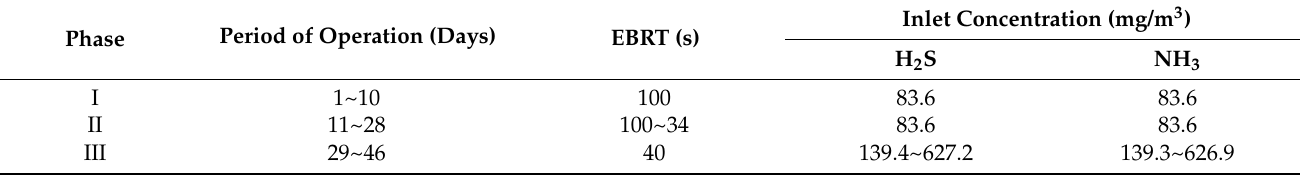
Table 2. Operating parameters of biotrickling